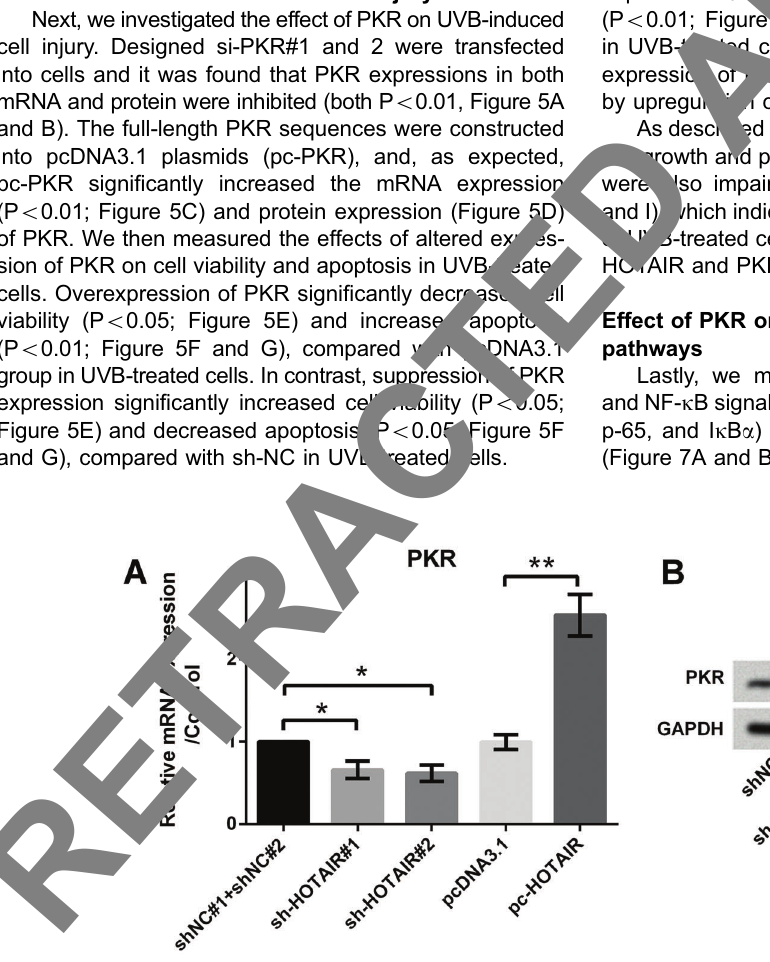
Figure 4. Effect of HOTAIR on PKR expression; A , qRT-PCR revealed overexpression of HOTAIR promoted the expression of PKR; B , Western blotting analysis revealed overexpression of HOTAIR promoted the expression of PKR. Data are reported as means ± SD. *P o 0.05; **P o 0.01 (ANOVA). HOTAIR: HOX antisense intergenic RNA; PKR: RNA-dependent protein kinase; qRT-PCR: quantitative real-time polymerase chain